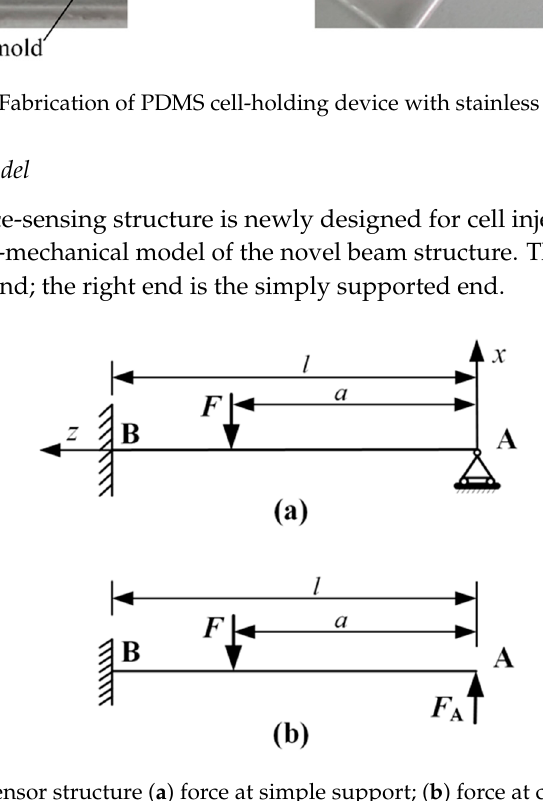
Figure 4. Simplified sensor structure ( a ) force at simple support; ( b ) force at clamped end. F , applied force; F A , force at A for zero movement at A ; a , distance between forces; l , length of beam.